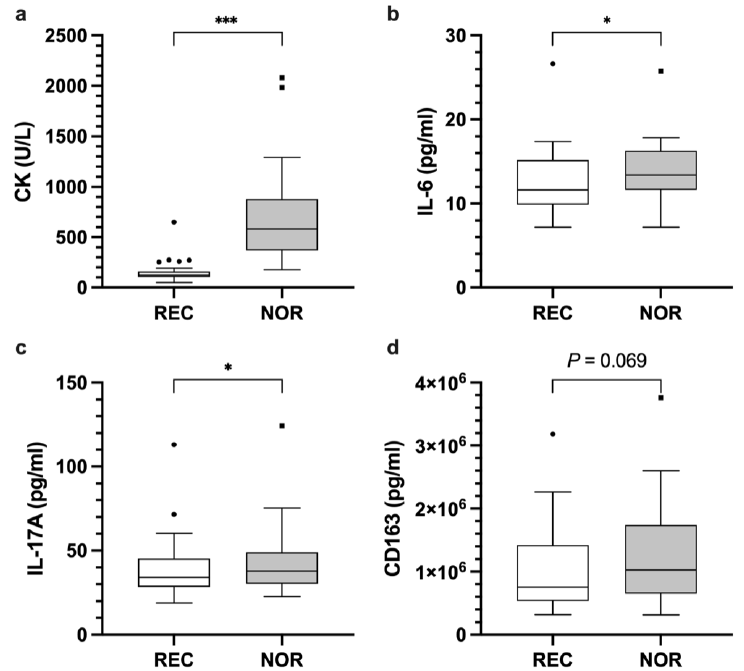
Figure 1. Concentration of CK ( a ), IL-6 ( b ), IL-17A ( c ), and CD163 ( d ) in athletes at REC and NOR time points across disciplines. (*) indicates p < 0.05 and (***) indicates p < 0.001. Raw data are shown.